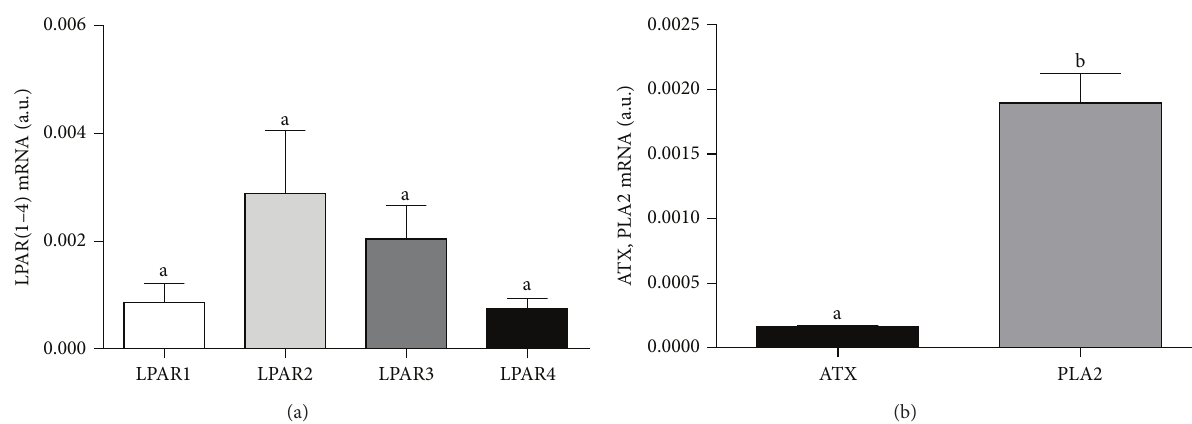
Figure 2: mRNA expression of (a) LPA receptors ( LPAR1–4 ) and (b) autotaxin ( ATX ) and phospholipase A2 ( PLA2 ) in cumulus cells. The values are expressed as mean ± SEM. Different letters indicate significant differences ( 𝑃 < 0.05 ), as determined by one-way ANOVA and Student’s 𝑡 -test, respectively.